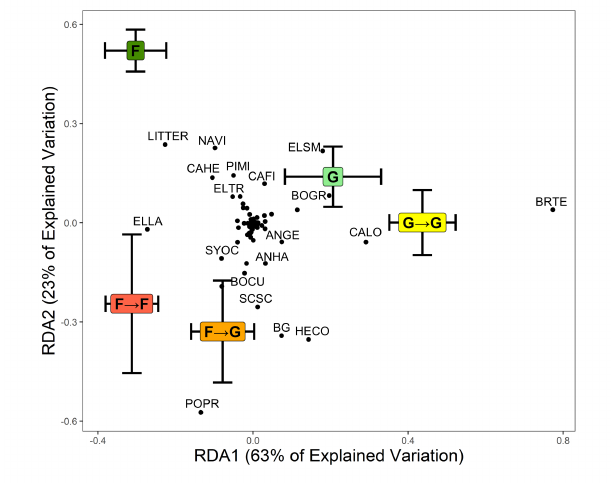
unburned grasslands along both Axis 1 and Axis 2. Fig. 3 . Redundancy Analysis (RDA) of herbaceous plant community and ground cover constrained by transition class (unburned forest sites [F], forest sites that burned at low severity and are expected to resemble unburned forest [F->F], forest sites that burned at high severity and are expected to resemble unburned grassland sites [F->G], unburned grassland sites [G], and grassland sites that burned and are expected to resemble unburned grassland [G->G].) Points represent species score locations. Outer points have species labels. RDA1 differentiates between regimes, while RDA2 represents variation driven by long-term legacy effects following